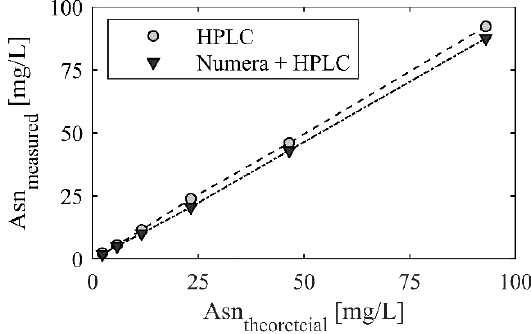
Figure 6. Evaluation of the error of the automated sampling system taking into account the sample draw, filtration, and transfer to the HPLC autosampler. Six standard concentrations of asparagine were analyzed with the developed amino acid derivatization method. The samples were once transferred to the HPLC via Numera (black upside-down triangles) and once injected directly from the HPLC autosampler (grey circles). Comparing the slopes, we receive an error of 4.5% resulting from the transfer and filtration (HPLC slope = 0.9926; Numera + HPLC slope = 0.9475).